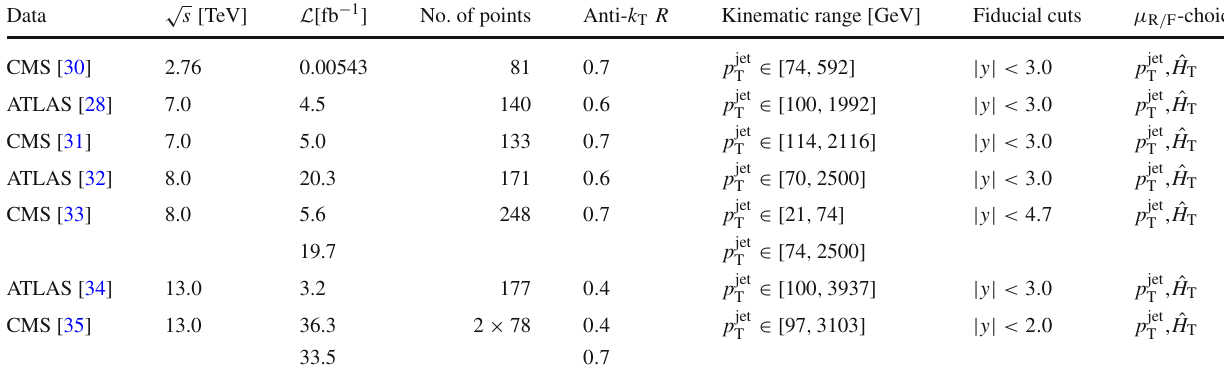
Table1 Anoverviewofinclusivejet p T datasetswith APPLfast inter- within a given range of rapidity y in the laboratory frame. Available polation grids for proton–proton collisions at the LHC. For each dataset choices for the central scales for μ R / F for the interpolation grids are √ s , the integrated luminosity L , the number the centre-of-mass energy listed of data points, and the jet algorithm are listed. Jets are required to be